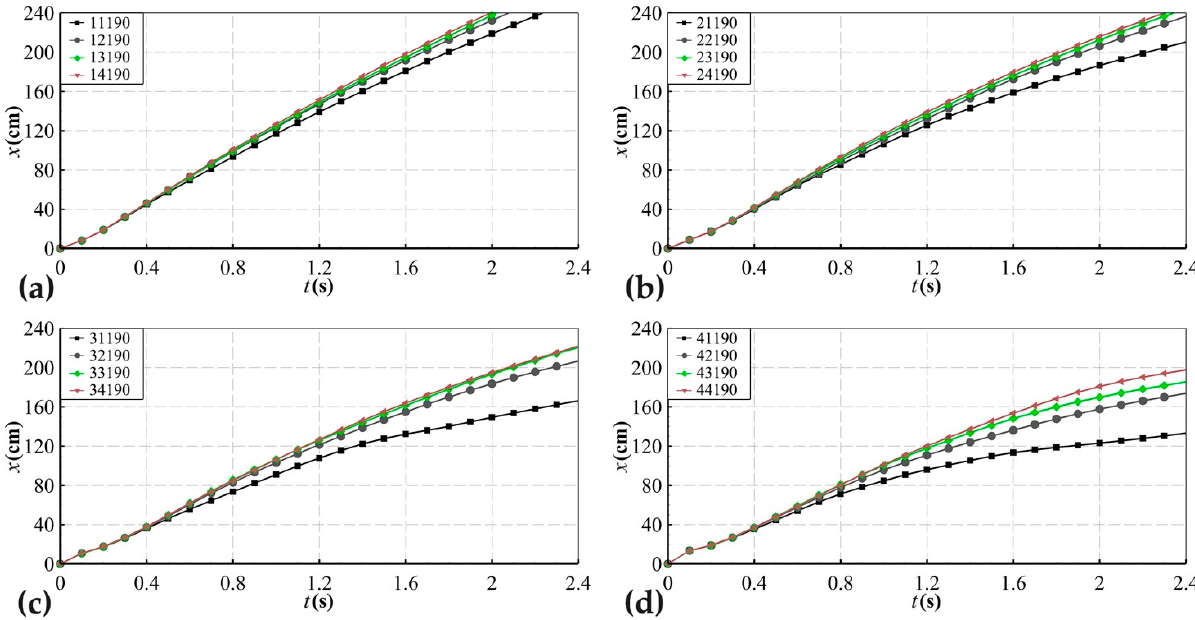
Figure 11. Comparison of the location of the center of gravity of the entire container group in the x direction after starting the drift at a 0.1 s interval. ( a ) N x = 1, N z = 1, and N y = 1, 2, 3, 4; ( b ) N x = 2, N z = 1, and N y = 1, 2, 3, 4; ( c ) N x = 3, N z = 1, and N y = 1, 2, 3, 4; and ( d ) N x = 4, N z = 1, and N y = 1, 2, 3, 4.